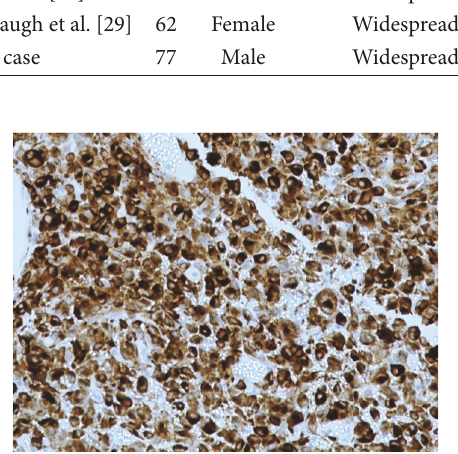
Figure 2: Melan A immunopositivity in the cells of the TURBT